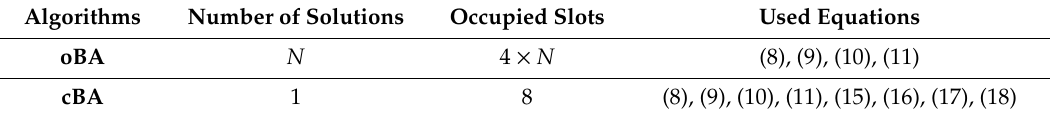
Table 3. Comparison of the number of variables for occupied memory slots in the cBA and oBA. Algorithms